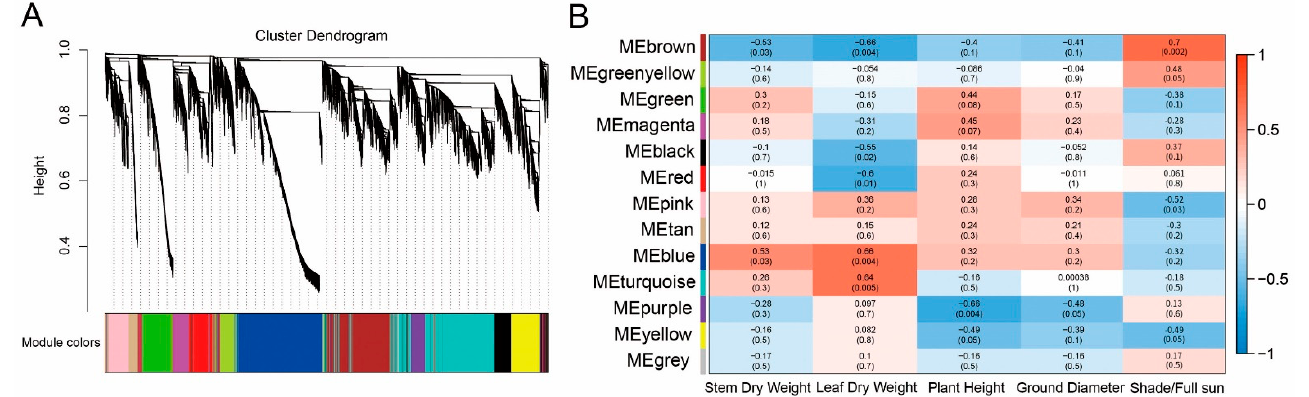
Figure 4. Co-expression network. ( A ) Gene cluster dendrogram and 13 gene module divisions, one of the major tree branches represents a module; different colors represent different modules. ( B ) Module–phenotype associations based on Pearson correlation analysis.